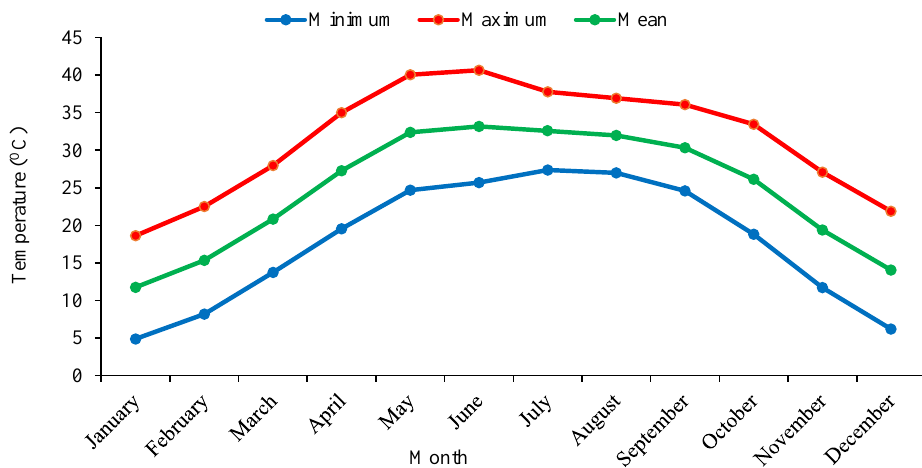
Figure 7. Long-term monthly temperature data. Table 1. Input parameters and source for WetSpass-M model.